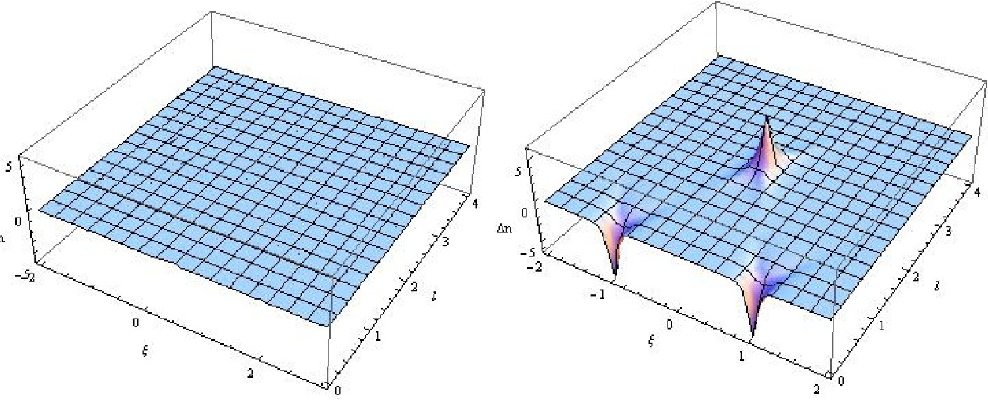
Figure 5 . The pro(cid:12)le of entanglement density for the 2nd Renyi entropy under the local operator quench in c = 1 free scalar CFT at the time t = 0 (left) and t = 1 (right) with (cid:11) = 0 : 1, trigger by the operator O = e i(cid:30) + e (cid:0) i(cid:30) . The horizontal and depth coordinate correspond to (cid:24) and l ,